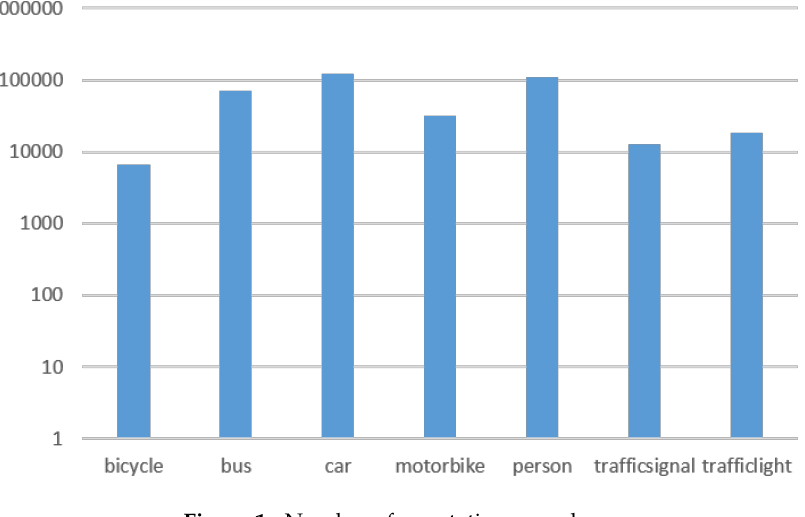
Figure 1. Number of annotations per class.